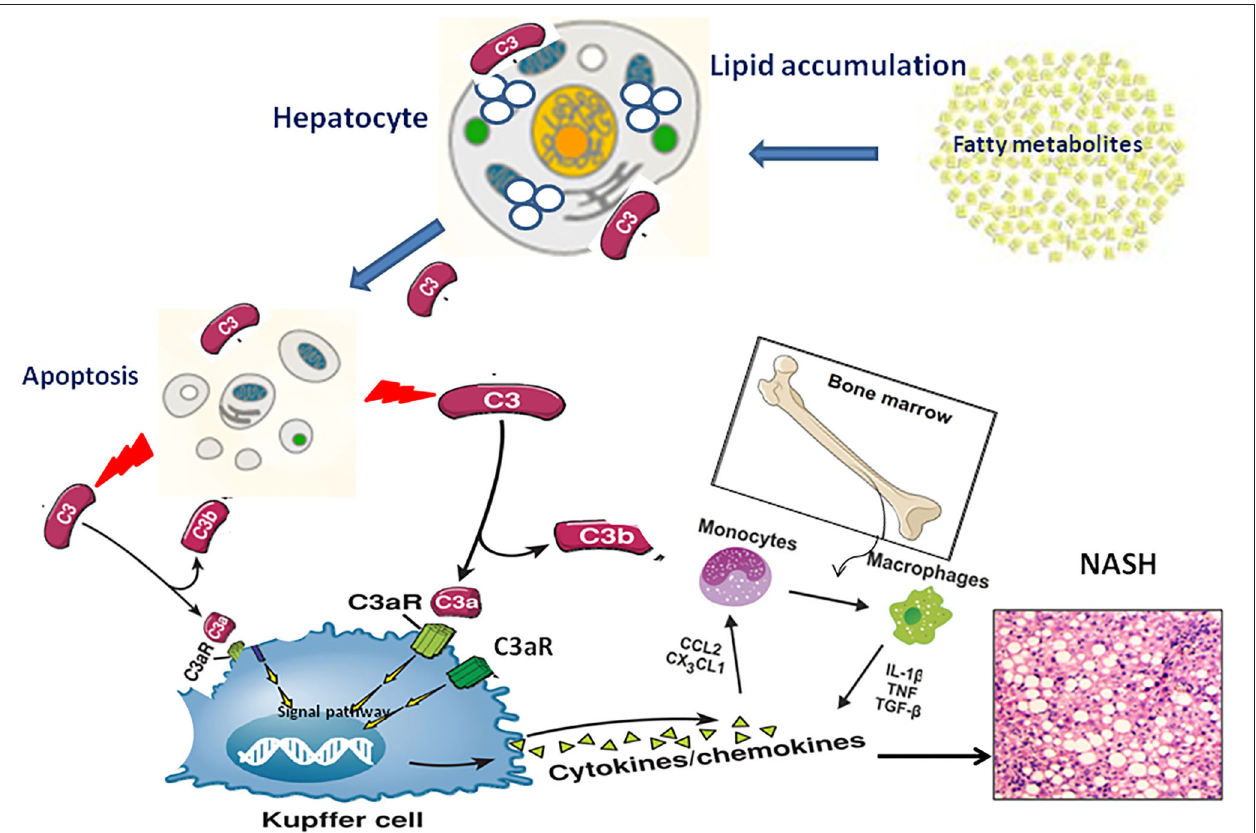
FIGURE 2 | The pathogenic mechanism of C3 activation in NAFLD progression through lipid accumulation, immune response and